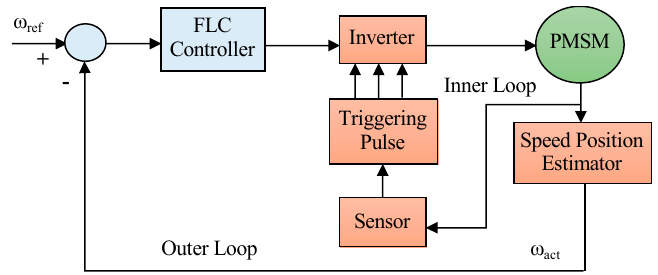
Figure 6. Basic structure of the PMSM FLC control.